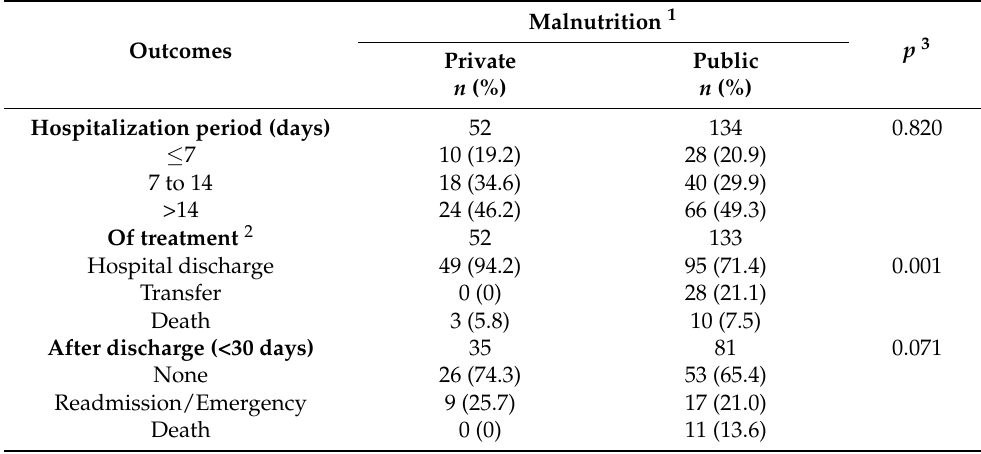
Table 5. Comparison of in-hospital and post-discharge ( ≤ 30 days) clinical outcomes of the sample, according to nutritional status and type of care, of hospitalized patients with heart failure, in the public and private health systems in Brazil, in the period April 2018 to January 2021. Malnutrition 1 p 3 Outcomes Private